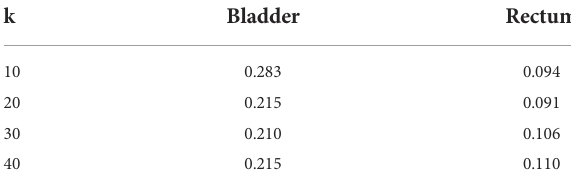
TABLE 3 Mean square error of predicted D 2cc using different k